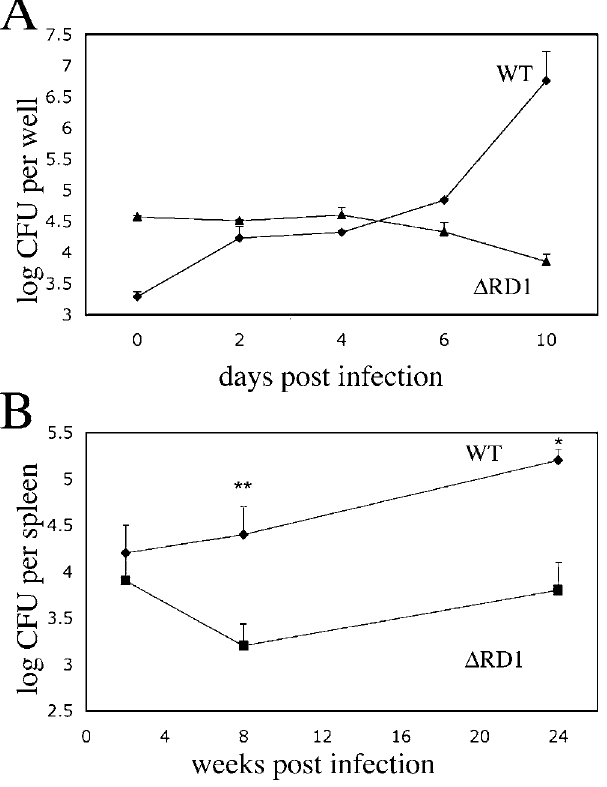
Figure 2. M. marinum D RD1 Is Attenuated In Vitro and In Vivo (A) Growth of M. marinum WT and D RD1 in J774 cells. Each time point represents the average of triplicate values. Error bars are 6 standard error of the mean (SEM). (B) WT and D RD1 bacterial numbers in frog spleens. Each time point represents the average colony counts from 3–5 frogs. Error bars are 6 SEM (* p (cid:1) 0.05, ** p = 0.016, unpaired Student’s t -test). Infecting doses were 5.8 3 10 5 CFU for WT and 1.2 3 10 6 CFU for D RD1. DOI: